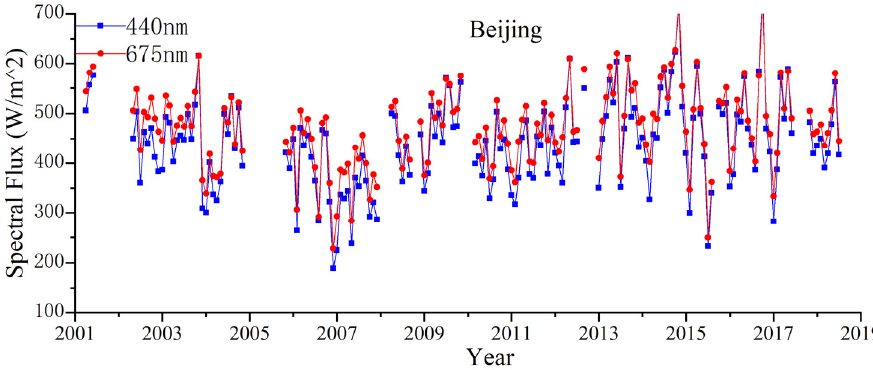
Figure 10. Monthly variations of downward spectral solar flux near surface at 440 and 675 nm in Beijing.